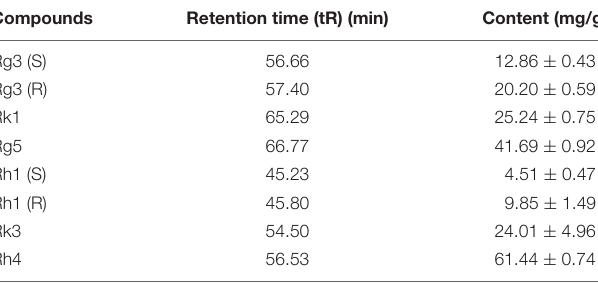
TABLE 2 | Composition and content of PPD and PPT analyzed by HPLC a